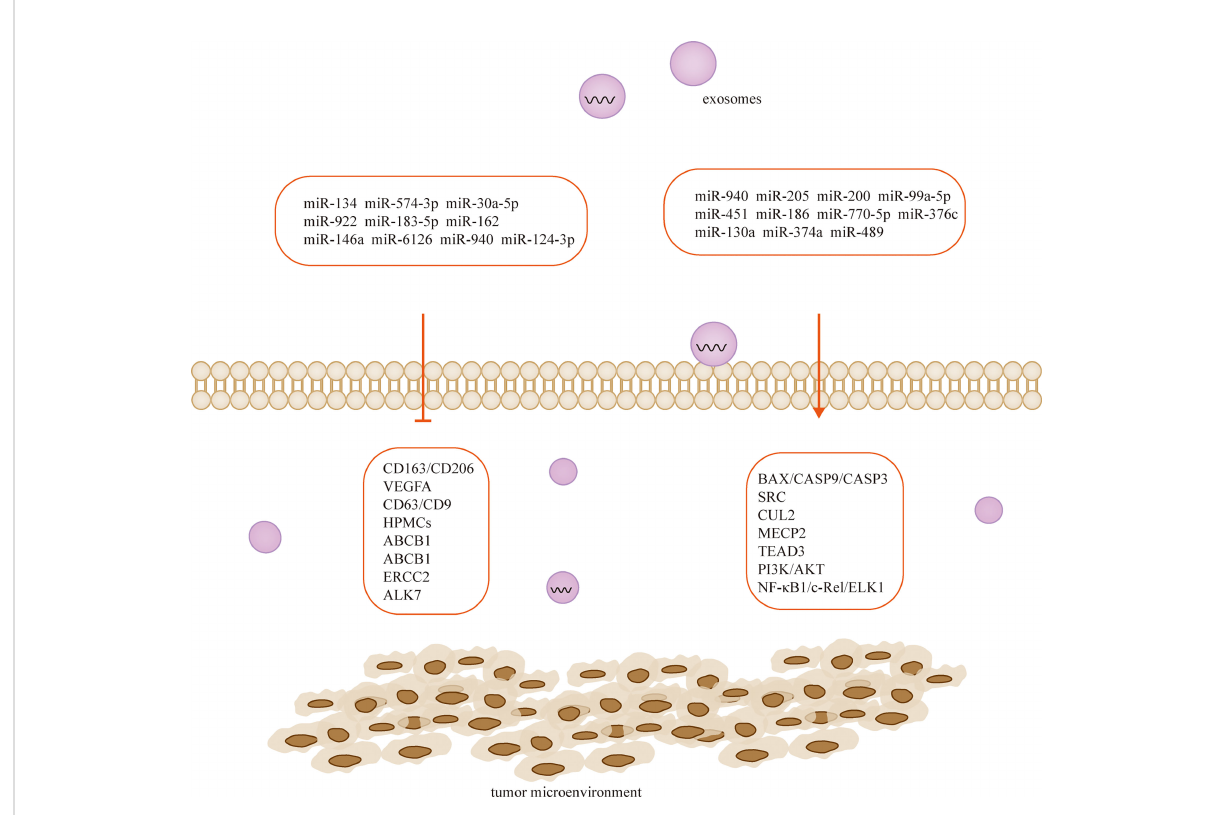
FIGURE 3 Exosome-derived miRNAs regulate TME and participate in the development of ovarian